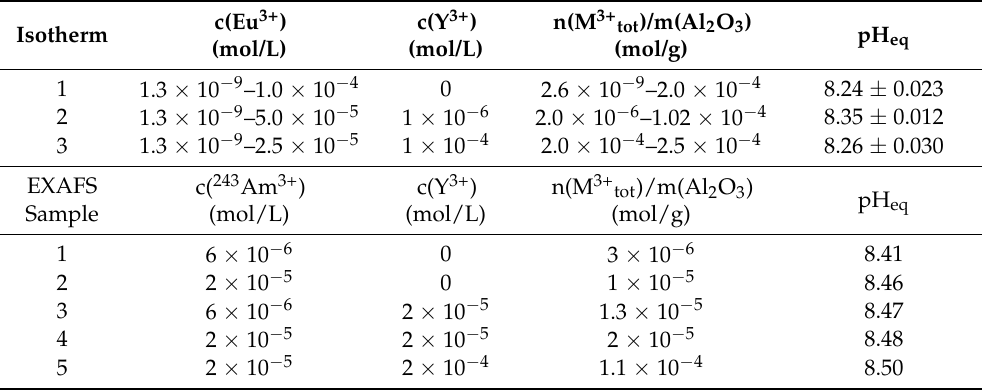
Table 1. Summary of sample parameters used in the isotherm and EXAFS investigations. The Eu 3+ concentration refers to the overall radioactive ( 152 Eu 3+ ) and inactive Eu 3+ added to the samples. The error given for pH eq is the standard deviation (1 σ ) of all sample pH values in one isotherm experiment. The precision of the pH measurements is ±